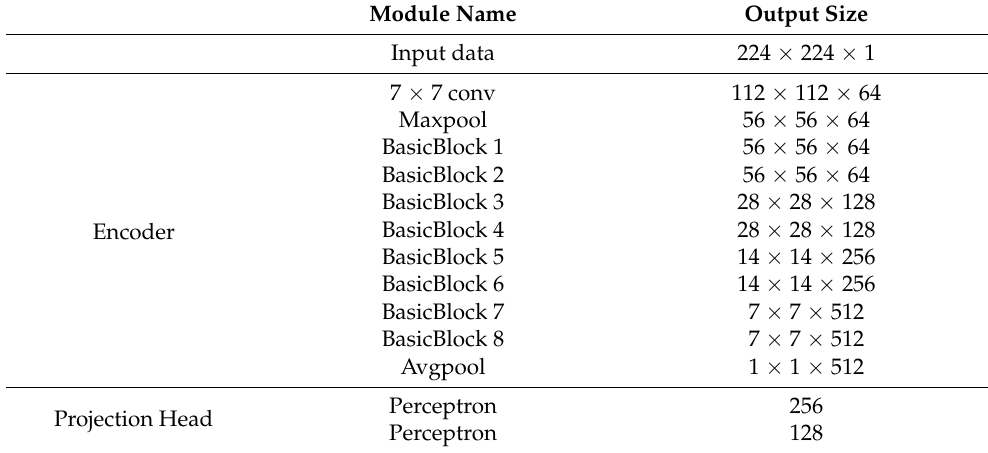
Table 2. SSCL network